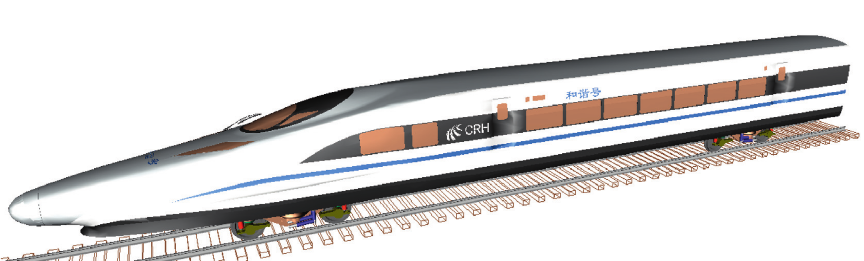
Figure 6: Vehicle dynamics